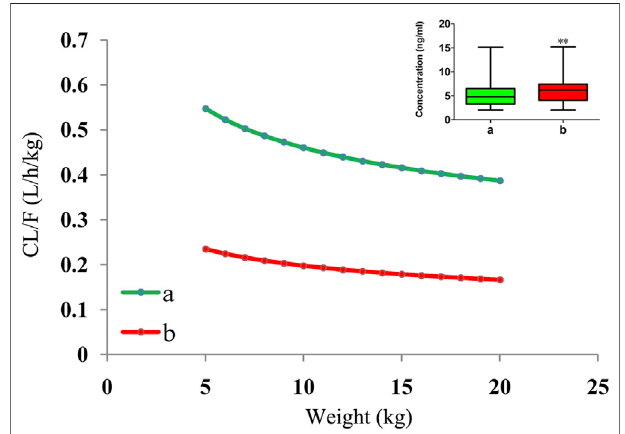
FIGURE 3 | Tacrolimus CL/F in CD children undergoing HSCT. a: without posaconazole. b: with posaconazole. **p < 0.01 vs. children without posaconazole (measured tacrolimus